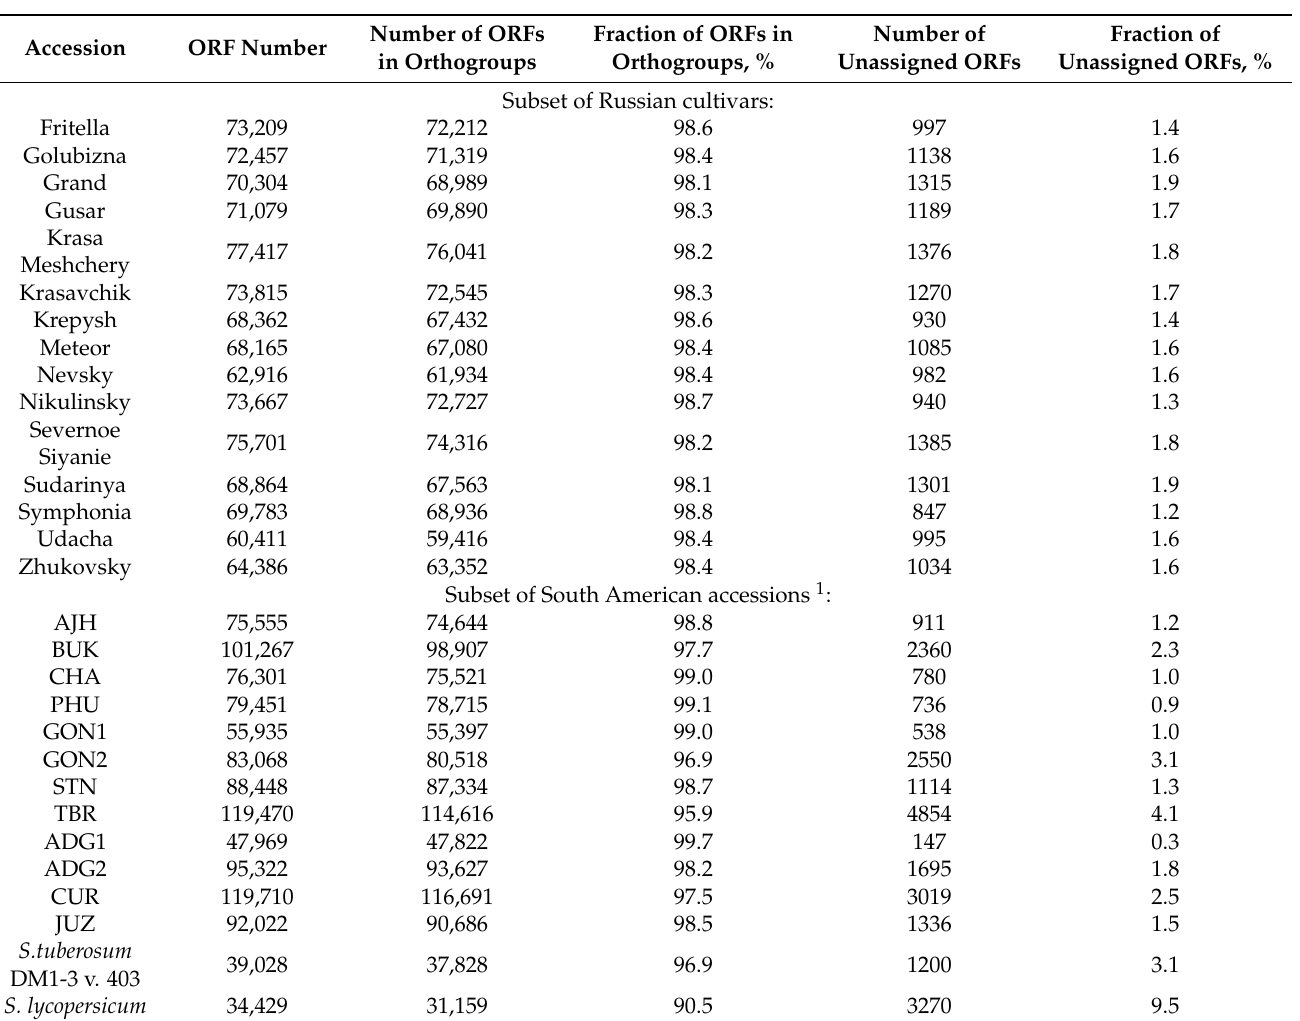
Table 2. Orthogroup statistics for ORFs from the genomes of Russian potato cultivars, South American accessions, potato DM1-3, and S. lycopersicum